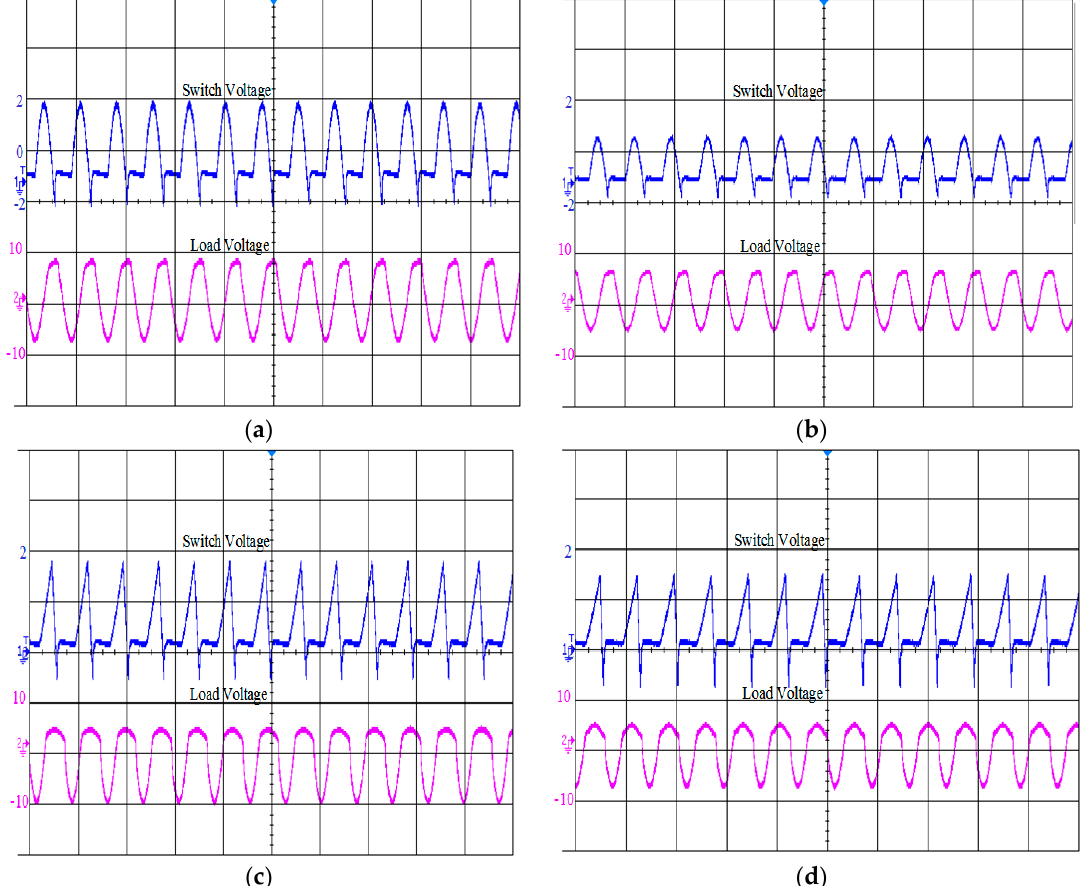
Figure 20. Experimental results of V sw and load voltage: ( a ) R L = 13.5 Ω at d = 40 mm; ( b ) R L = 21 Ω at d = 40 mm; ( c ) R L = 13.5 Ω at d = 60 mm; and ( d ) R L = 21 Ω at d = 60 mm.